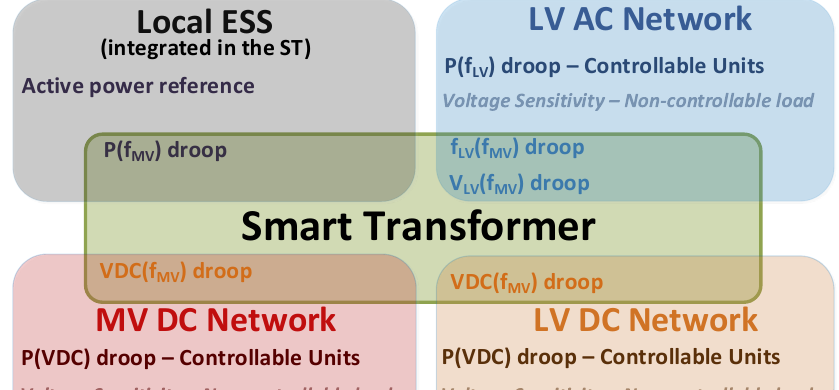
Figure 11. Advanced functionalities to be exploited by the